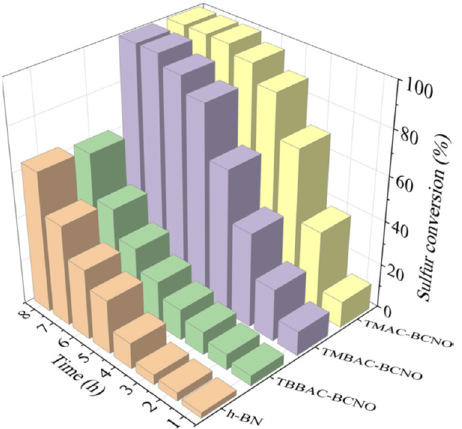
Figure 13. The results of aerobic ODS tests on DBT model diesel for the BCNO catalysts [96].